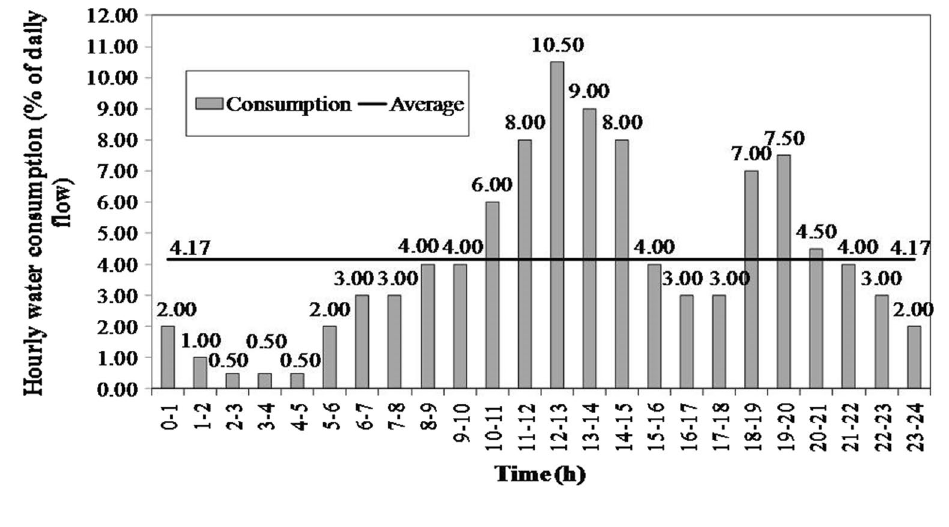
Fig. 6 Average daily solar inso- lation